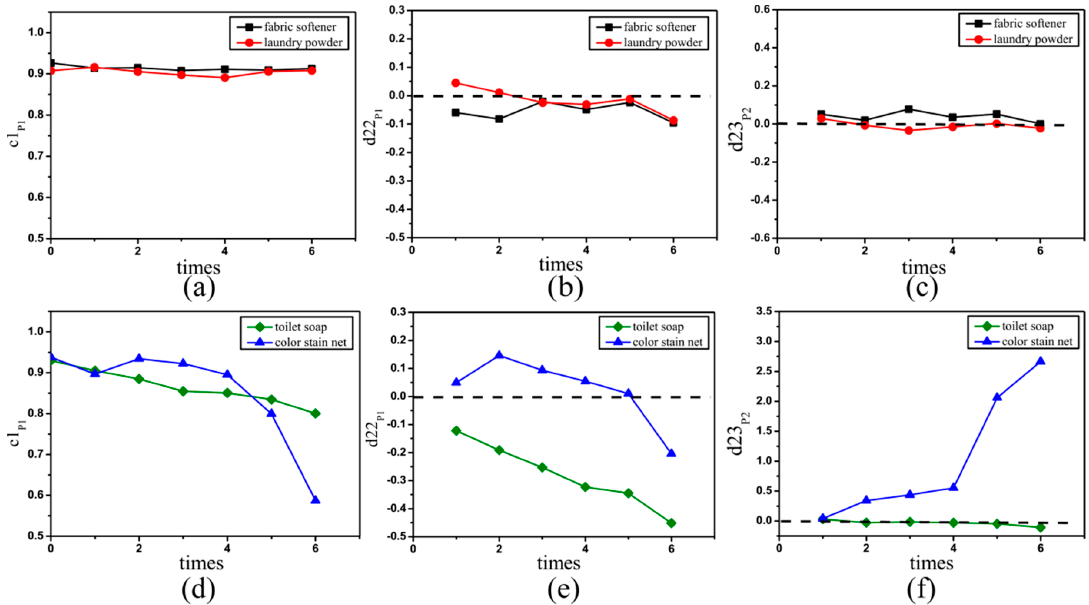
Figure 5. FDH parameters c 1 p1 (left), d 22 p1 (middle) and d 23 p 2 (right) of silk samples washed by different detergents. ( a – c ) are the values of three parameters for the silk samples washed by the group A detergents: fabric softener in black square lines and laundry powder in red dot lines; ( d – f ) are the values of three parameters for the silk samples washed by the group B detergents: toilet soap in green diamond lines and color stain net in blue triangle lines. The horizontal axis represents the washing times.